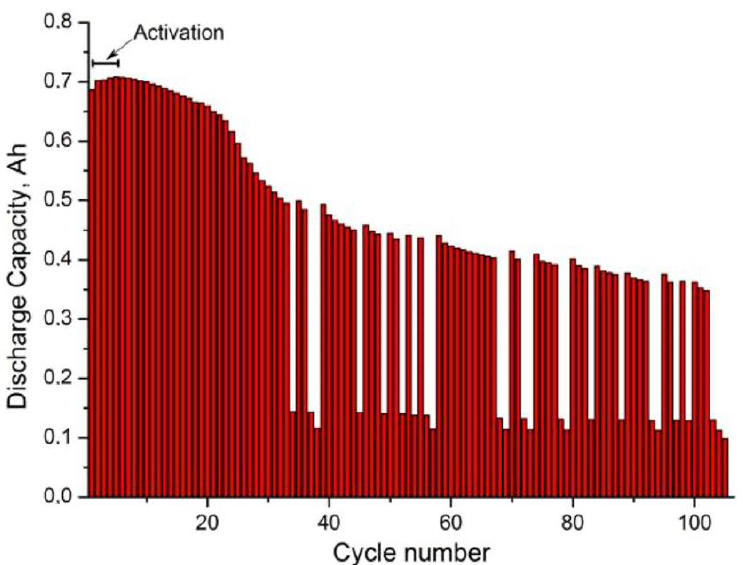
Figure 1. Discharge capacity versus cycle number of the aged cell. The first 5 cycles present a capacity increase due to activation of the cell. The very low capacity is due to a failure with the cycling instrument. Reprinted from Journal of Power Sources , Vol. 268, Luchkin, S.Y.; Amanieu, H.Y.; Rosato,